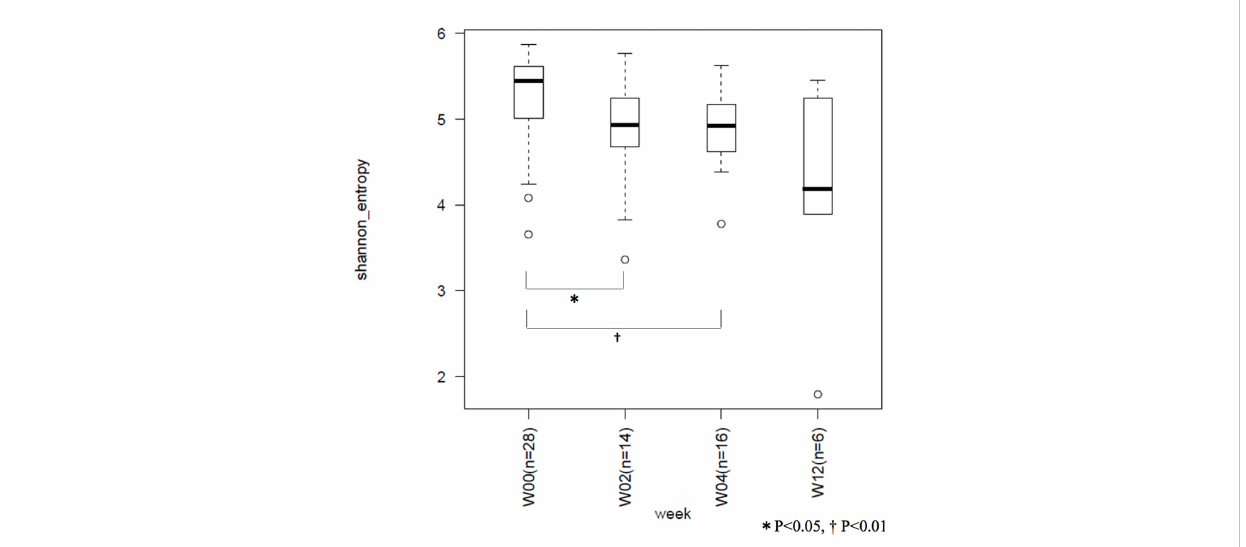
FIGURE 3 Between-group comparison of Shannon coef fi cients. W00, W02, W04, and W12 represent before operation and 2-, 4-, and 12-weeks after operation, respectively. Microbiome diversity showed a decrease with